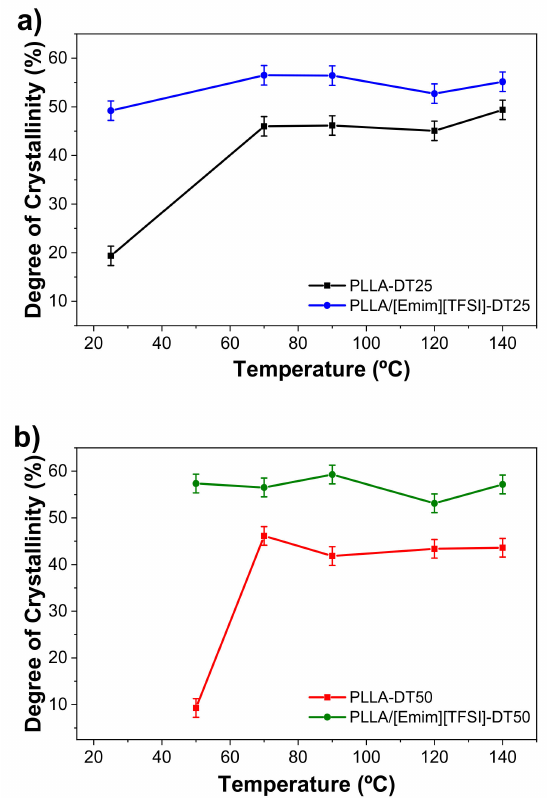
Figure 5. Degree of crystallinity as a function of the post-thermal treatment temperature for the PLLA-based films dried at: ( a ) 25 ◦ C; and ( b ) 50 ◦